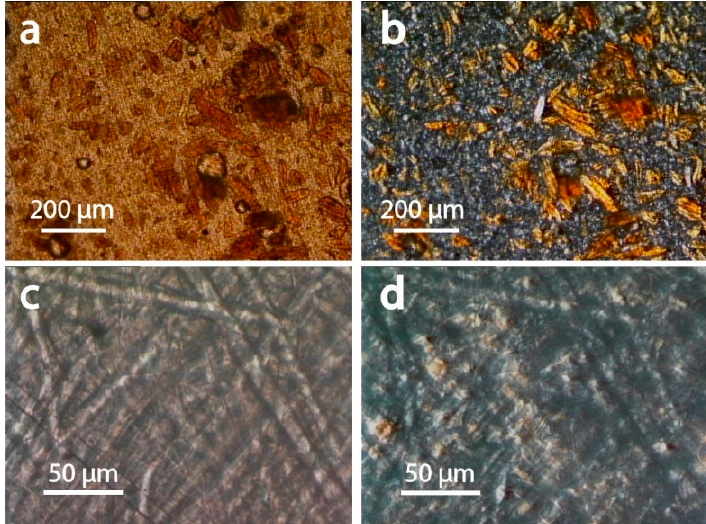
Figure 7. Transmission microscopy images obtained for ( a ) UPM Formi-PLA based composites and ( c ) GF-PA6 based composites. In ( b , d ) the respective images are obtained with the sample between cross polarizers highlighting the crystalline nature of the fibers in UPM Formi-PLA in ( b ) and of the amorphous nature of the glass fibers in ( d ).